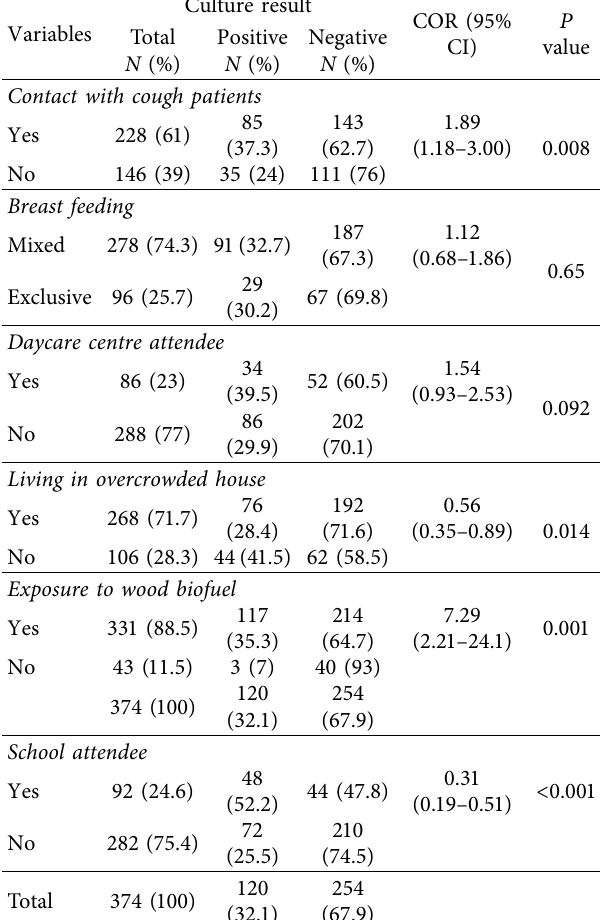
Table 3: Bacterial throat culture and other explanatory variables of children with 2–5 years of age with suspicion of bacterial tonsillitis at Hargeisa Group of Hospital ( N � 374).